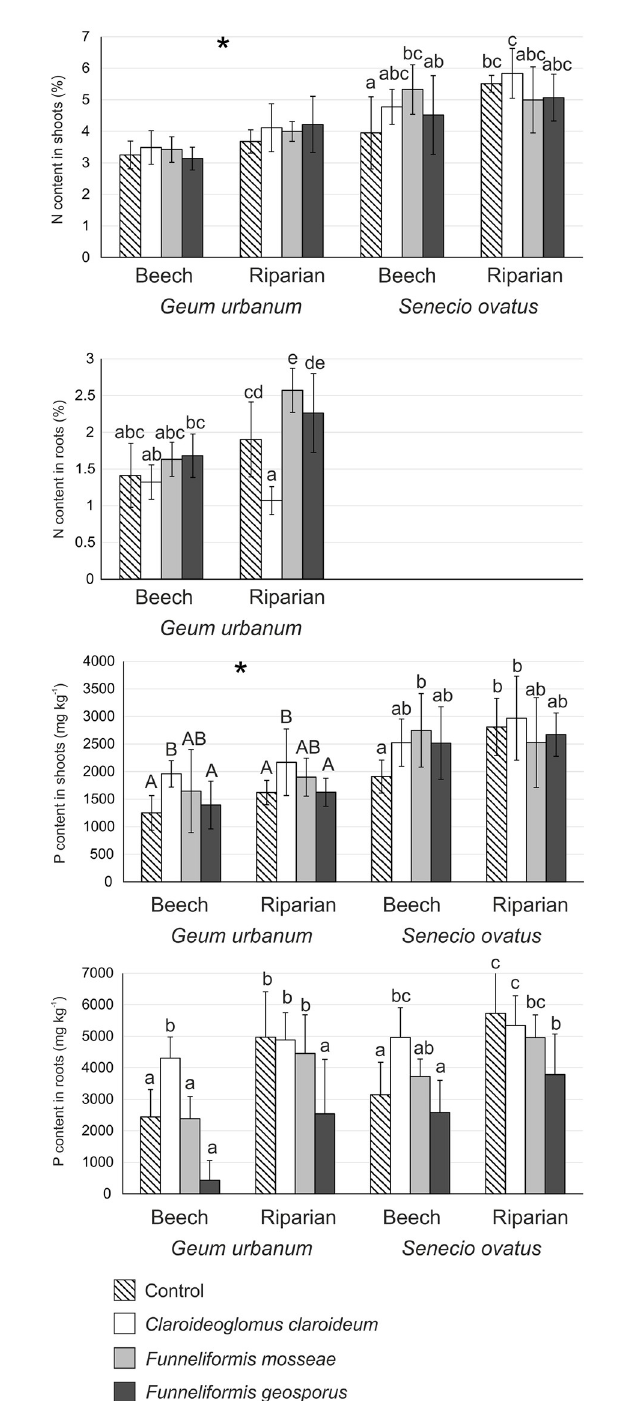
Fig 3. Contents of nitrogen and phosphorus (milligrams per kilogram dry weight; mean ± SD) in the shoots and roots of Geum urbanum and/or Senecio ovatus grown in beech and riparian soils. Within each plant species, lowercase letters above the bars indicate statistically significant interaction between fungus and soil effects; uppercase letters indicate the significant main effect of fungus; different letters above the bars indicate statistically significant differences; the asterisk ( � ) indicates the significant main effect of soil; for each, p < 0.05. See Table 2 for details on the main effects and interactions.